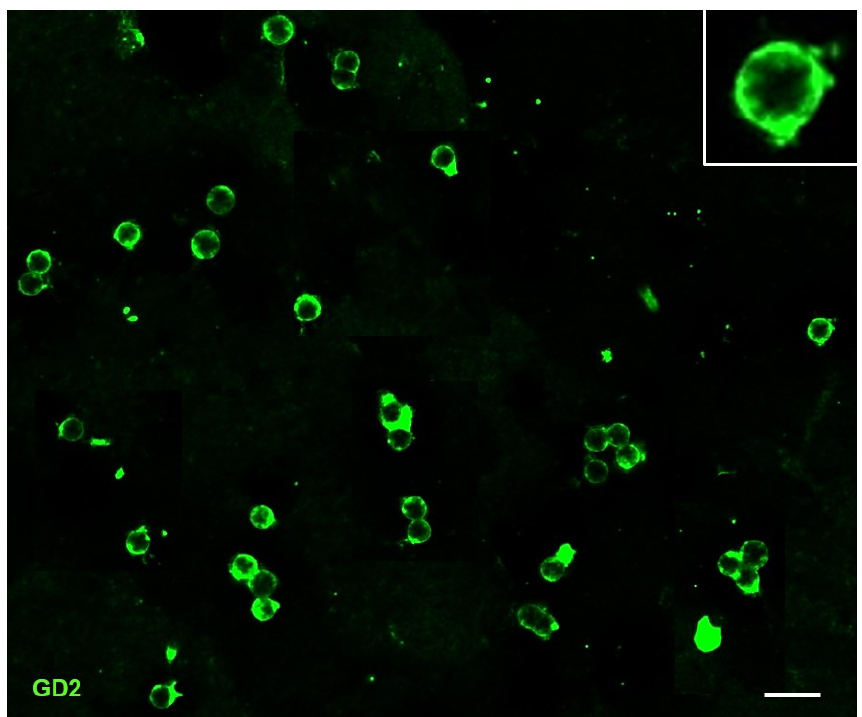
Figure 2. Exosomes derived from peripheral blood samples of the NB patient expressed GD2 marker (green staining). Scale bar: 200 nm. In the inset is visualized an enlarged exosome.